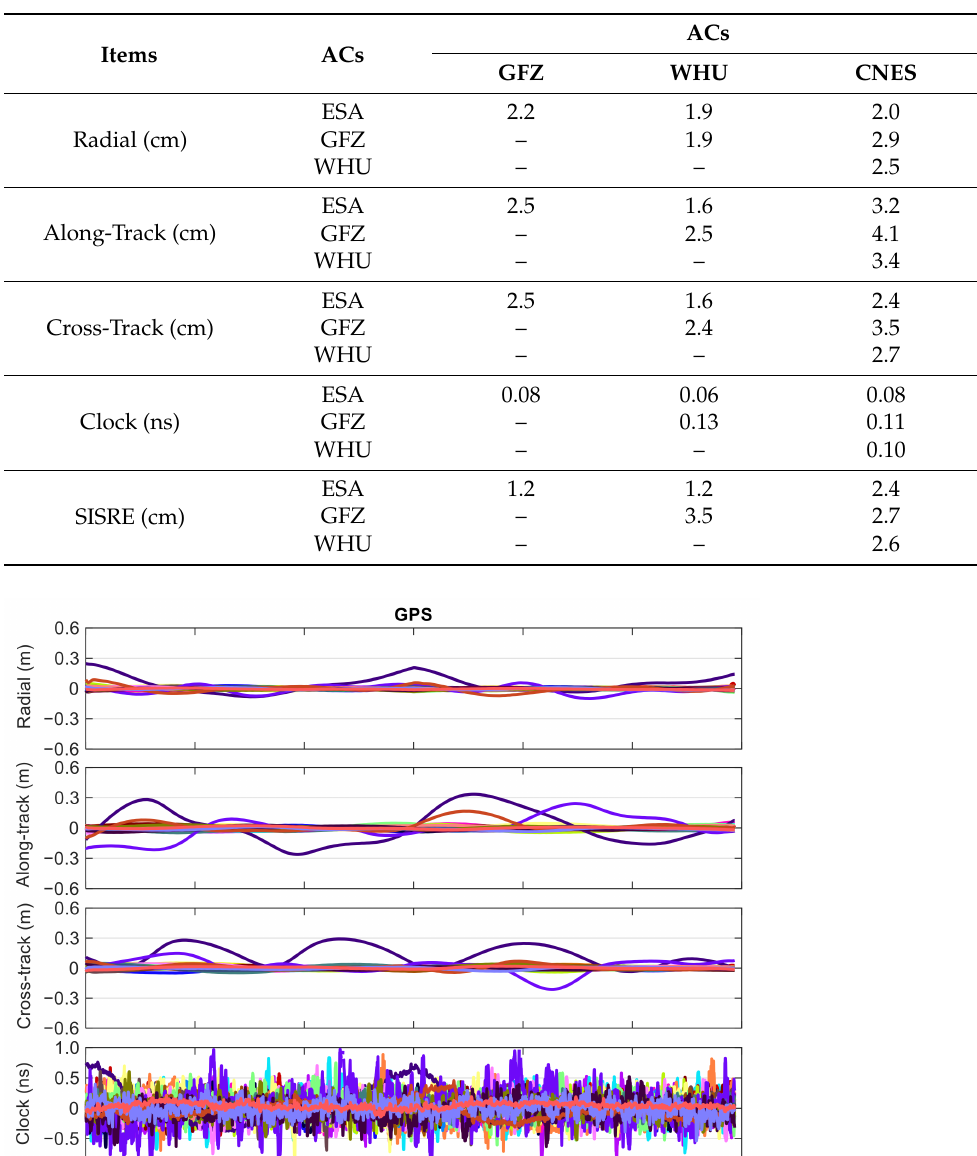
Table 2. RMSs of epoch-wise differences of precise satellite orbit and clock corrections among different ACs as well as SISRE statistics for GPS satellites.